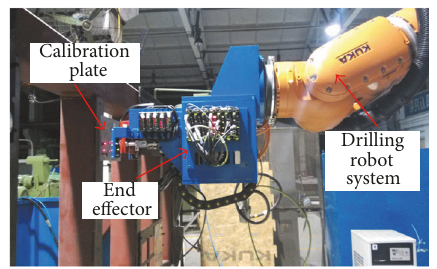
Figure 10: Base detection experiment of robot drilling system.